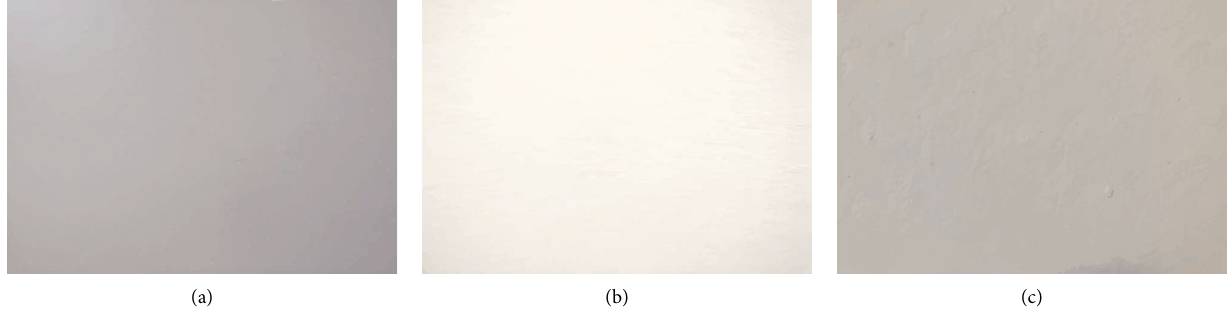
Figure 3: (a) Flat digital image captured by the digital camera in a smartphone Huawei Mate Pro; (b) flat digital image captured by the digital camera in a smartphone OnePlus 3T; (c) flat digital image captured by the digital camera in a smartphone iPhone 7.